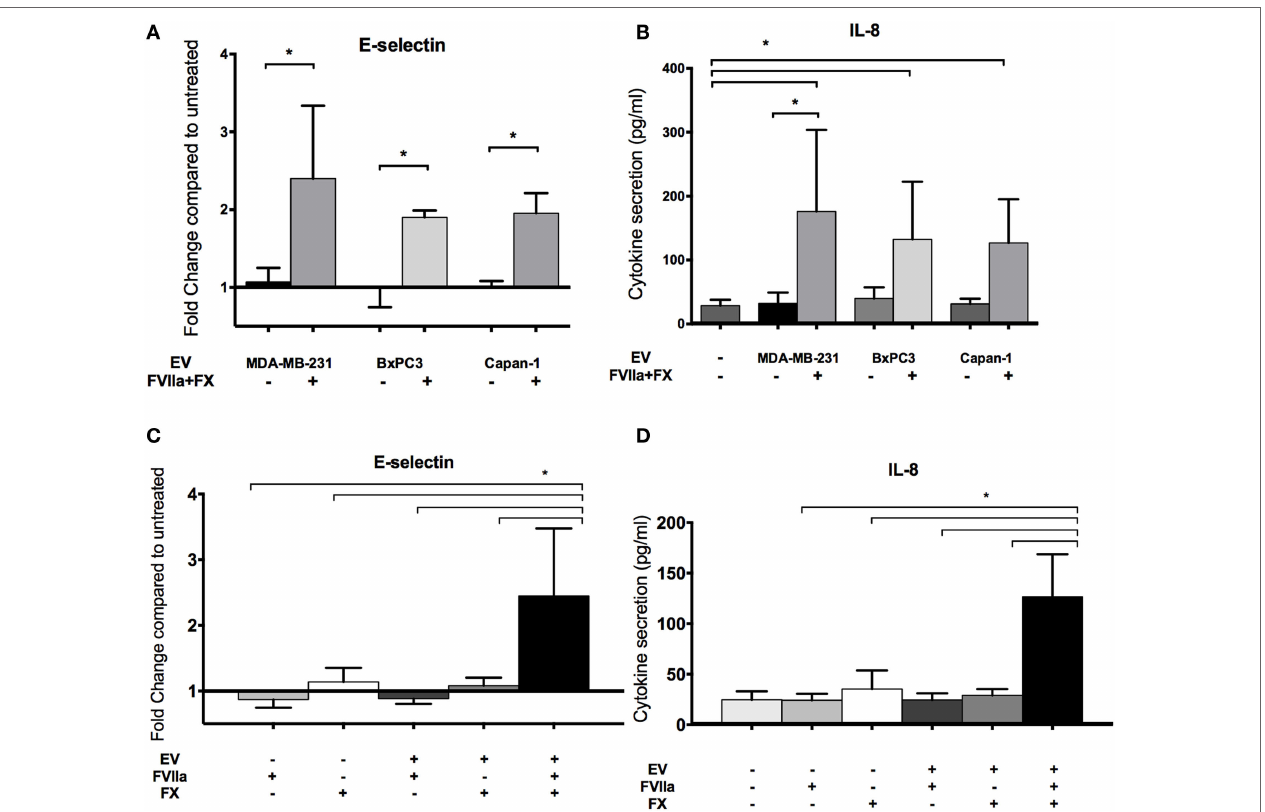
FigUre 3 | Increased endothelial E-selectin expression and interleukin-8 (IL-8) secretion after exposure to tumor-derived extracellular vesicle (EV) require factor VIIa (FVIIa) and FX. E4 + human umbilical vein endothelial cells were exposed to EV (with or without FVIIa and FX) derived from MDA-MB-231, BxPC3, and Capan-1 tumor cells for 6 h. (a,c) Endothelial E-selectin expression and (B,D) IL-8 secretion were evaluated using a cell-based ELISA and ELISA on conditioned media, respectively. Increased endothelial E-selectin expression (a) and IL-8 secretion (B) were observed when EVs were pretreated with 10 nM FVIIa and 150 nM FX. Both FVIIa and FX were required for these endothelial responses (c,D) . All experiments were repeated three to four times. * p <